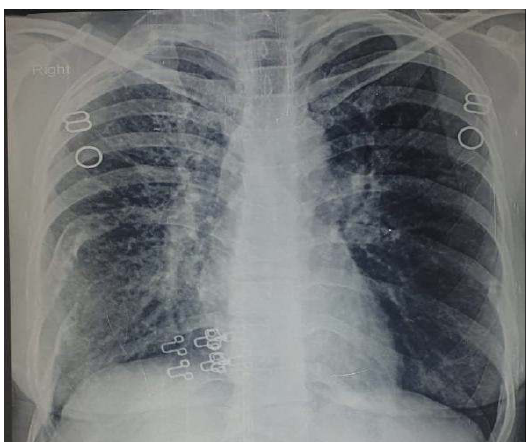
Figure 1: Chest x-ray: reticular opacity in right upper lobe and left hilar prominence